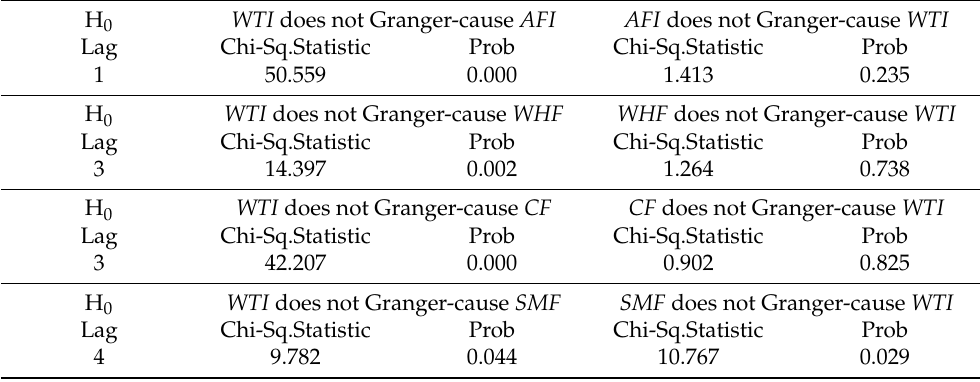
Table 6. Results of Granger causality test.